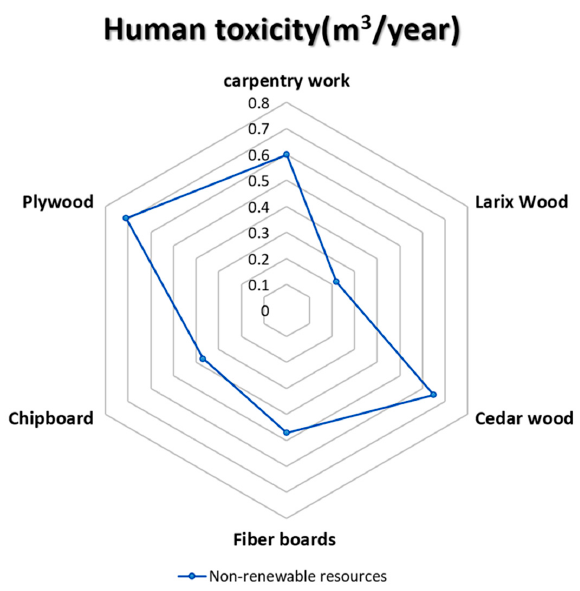
Figure 10. The impact of human toxicity on the selective façade wooden material [68–72].